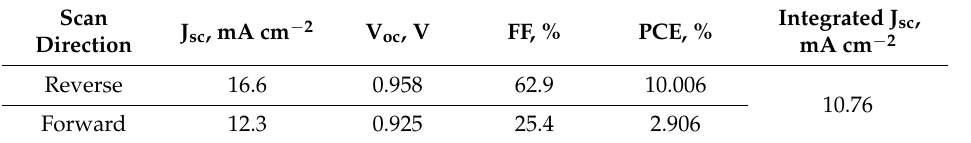
Table 2. Solar cell performance parameters for the champion